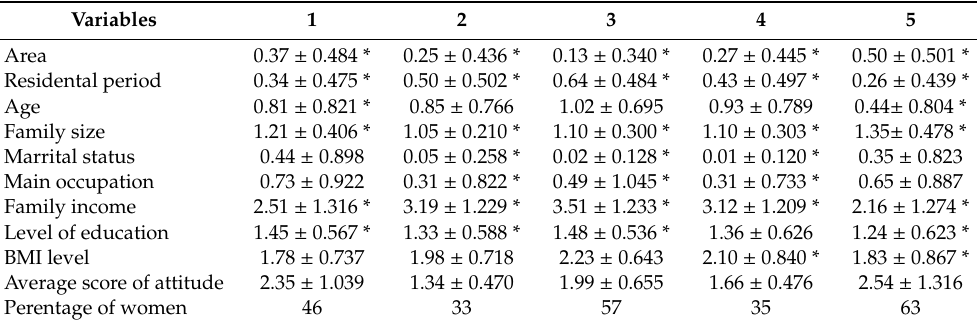
Table 5. The average score of food and nutrition-related attitude (mean,